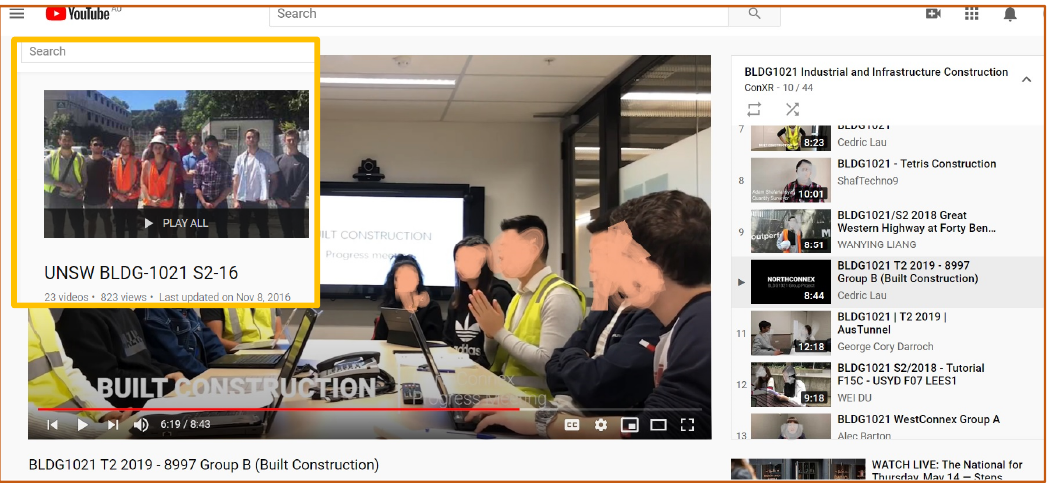
Figure 4. Students’ presentations of their role-play practice uploaded on YouTube by themselves.